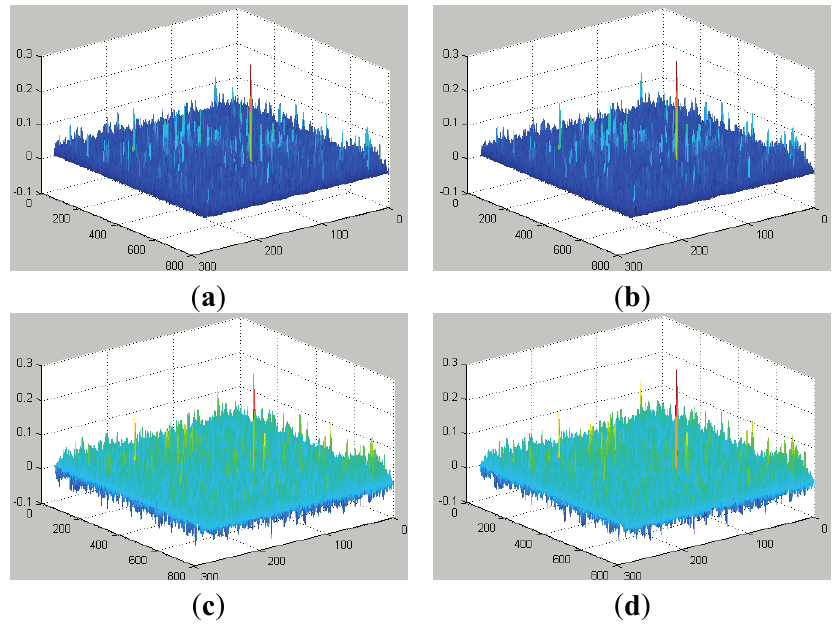
Figure 20. 3-D plots of the detection results of target F3. ( a ) ACE-R; ( b ) ACE-C; ( c ) ASMF-R ( n = 1); ( d ) ASMF-C ( n =